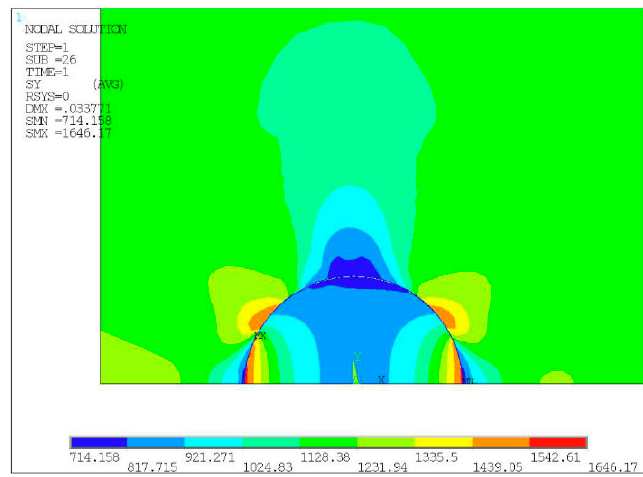
Figure 4. Stress cloud chart result of specimen No.